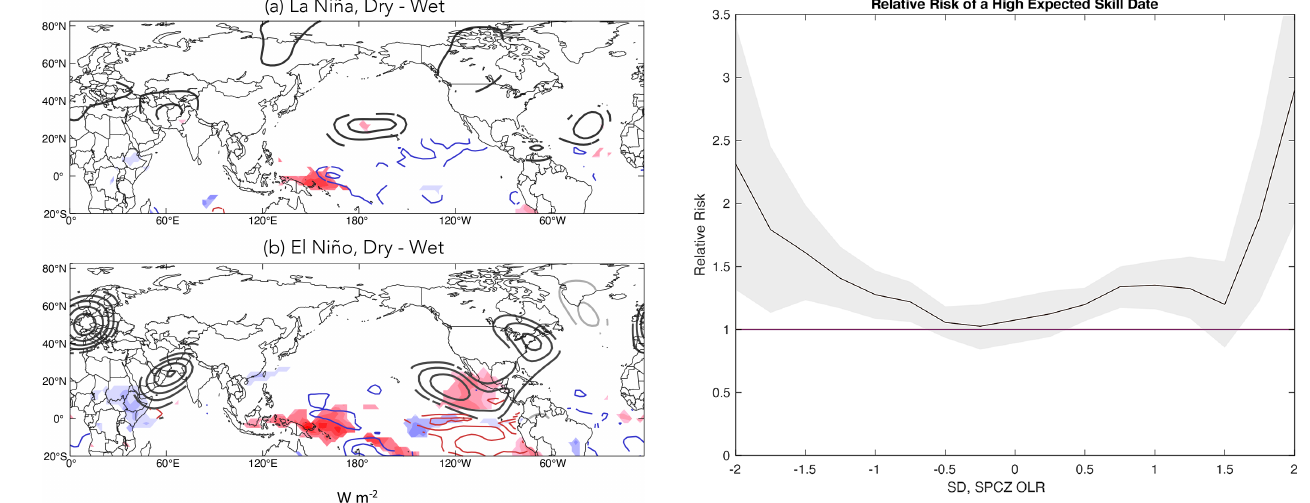
Figure 13. As in Fig. 7 but for using the standard deviation of the SPCZ OLR anomaly time series, calculated using the boxed region in Fig. 10 and for weeks 3–4 expected